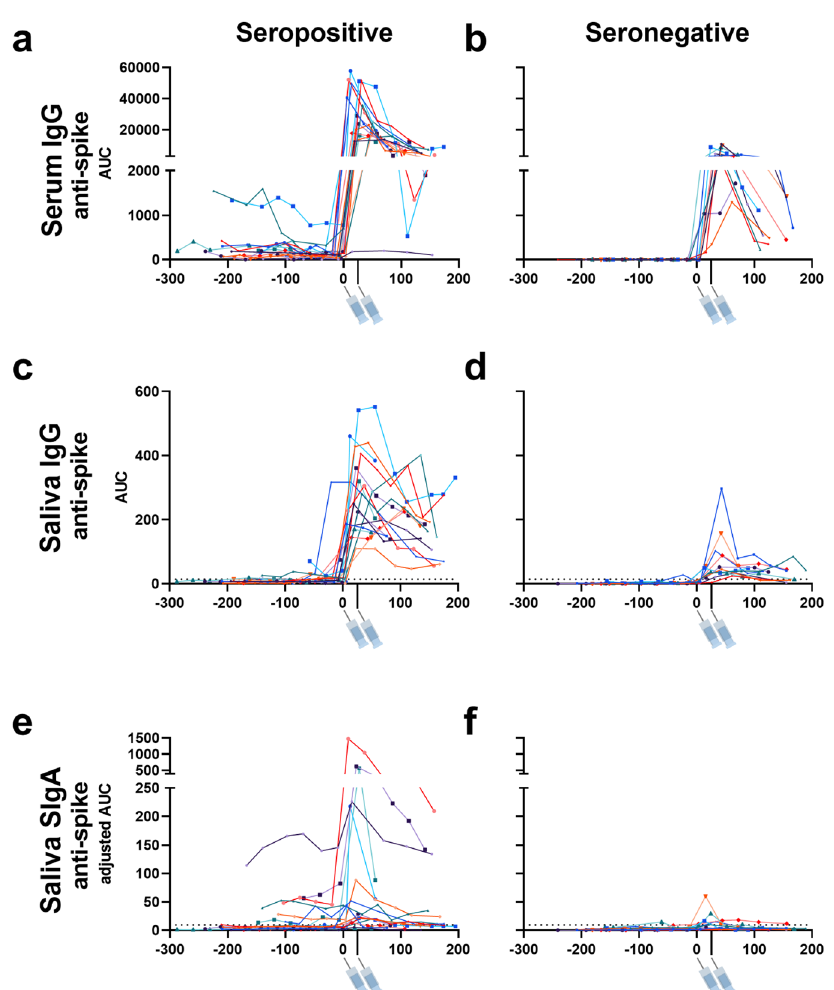
Fig. 1 | Time course of vaccine-induced serum and mucosal anti-SARS-CoV-2 antibody titers in adult participants with or without previous SARS-CoV-2 infection. Anti-SARS-CoV-2 spike IgG titers in serum ( a , b ), anti-SARS-CoV-2 spike IgG titers in saliva ( c , d ), and anti-SARS-CoV-2 spike SIgA titers in saliva ( e , f ) col- lectedfrom18individualswithpreviousSARS-CoV-2infection(seropositive)and11 individuals without previous SARS-CoV-2 infection (seronegative) prior to and after vaccination. 6 – 13 different timepoints were assessed per individual. X -axis values represent days post- fi rst vaccination and Y -axis values represent antibody